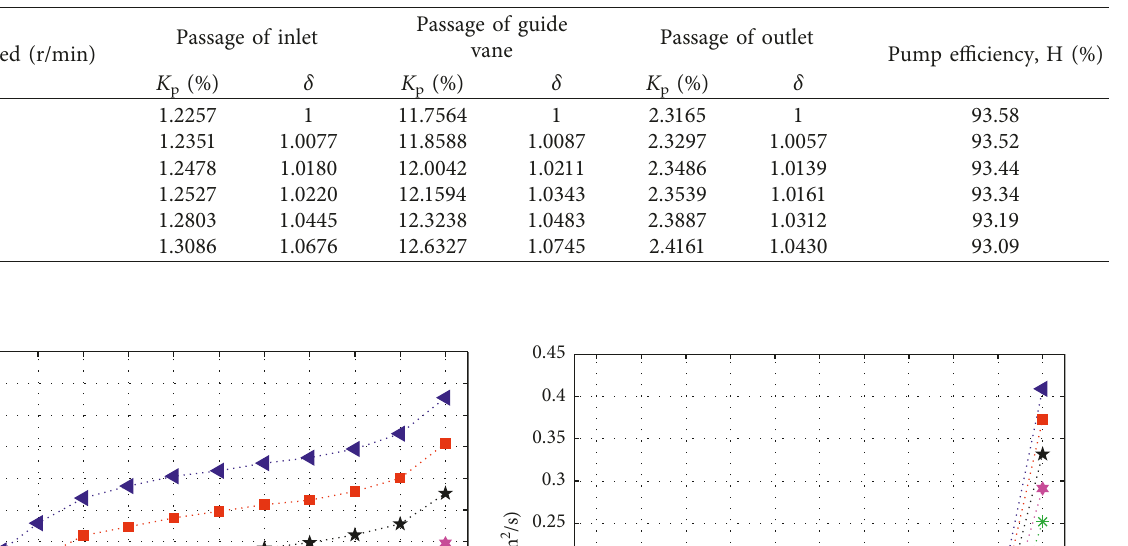
Figure 12: Comprehensive characteristic curve. Table 9: Hydraulic loss of the passages.